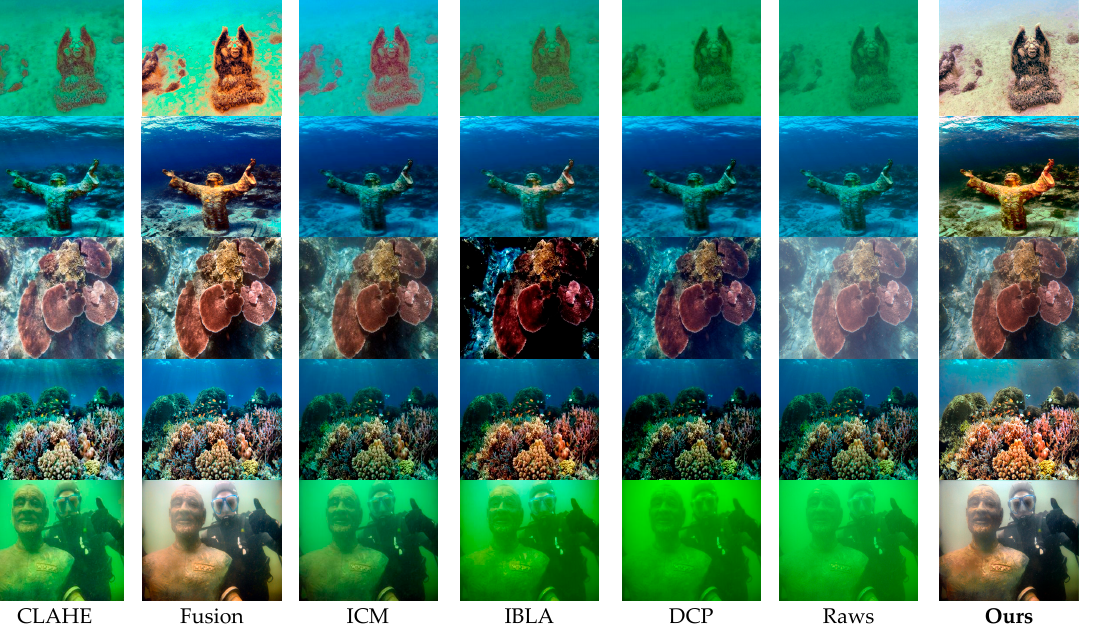
Figure 7. Comparison with traditional methods.